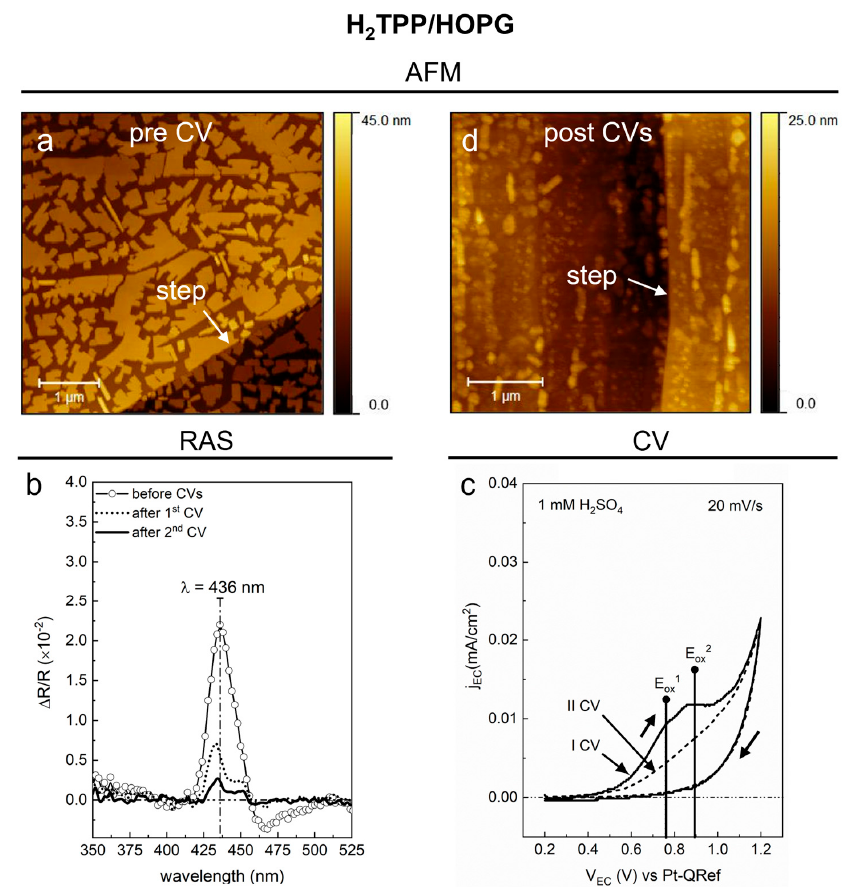
Figure 3. ( a ) (5 × 5) µm 2 topographic image of the 6 nm thick H 2 TPP/HOPG sample; the white